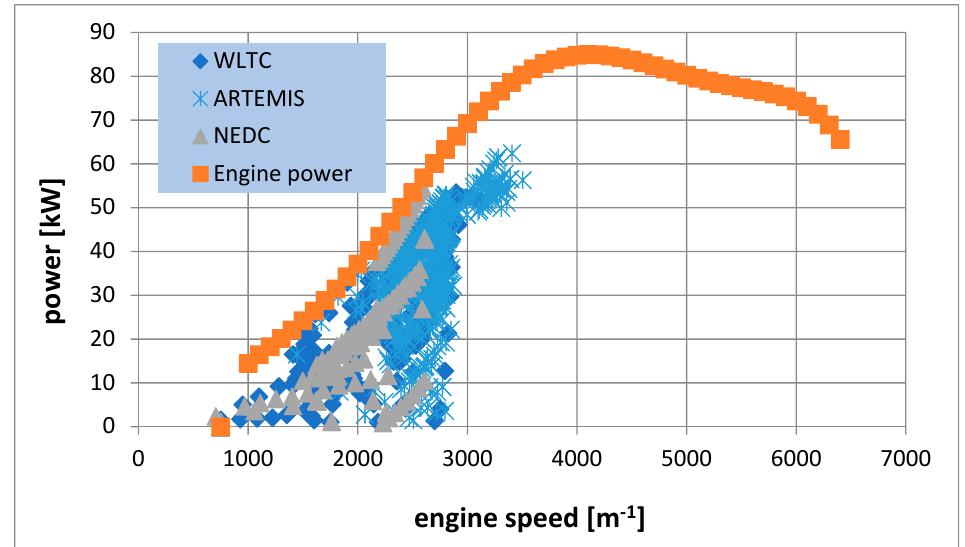
Figure 3. The required road load power versus engine speed for phases of ARTEMIS, WLTC and NDEC driving cycles corresponding to road traffic conditions.